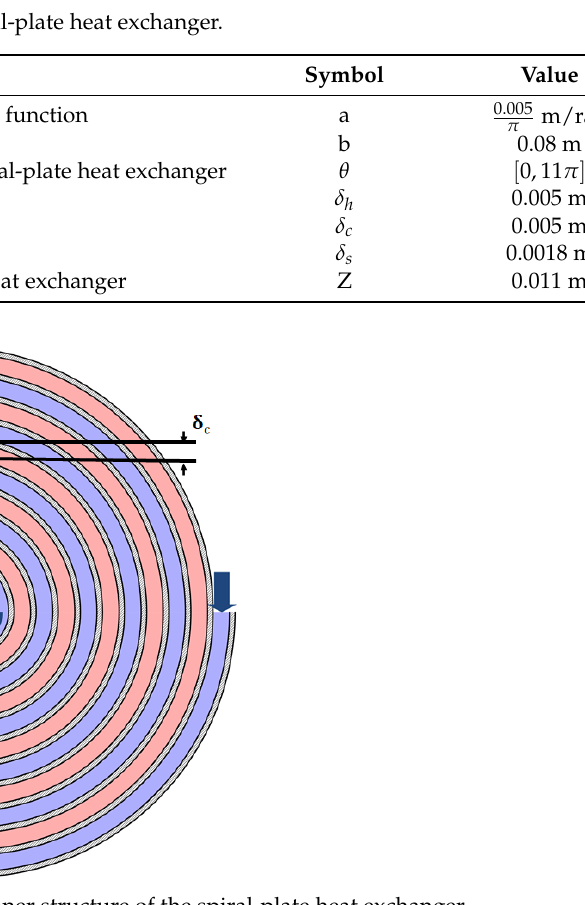
Figure A2. Cross-section of the inner structure of the spiral-plate heat exchanger. Heat exchangers are typically classified into parallel-flow and count-flow types based on their arrangement. In the parallel-flow type, both the input and the output of the two directional fluids (one a hot fluid, the other a cold fluid) flow in the same direction. In a counter-flow heat exchanger, the hot fluid and cold fluid flow in opposite directions. In this paper, we study a fractional order derivative model of a spiral counter-flow type heat